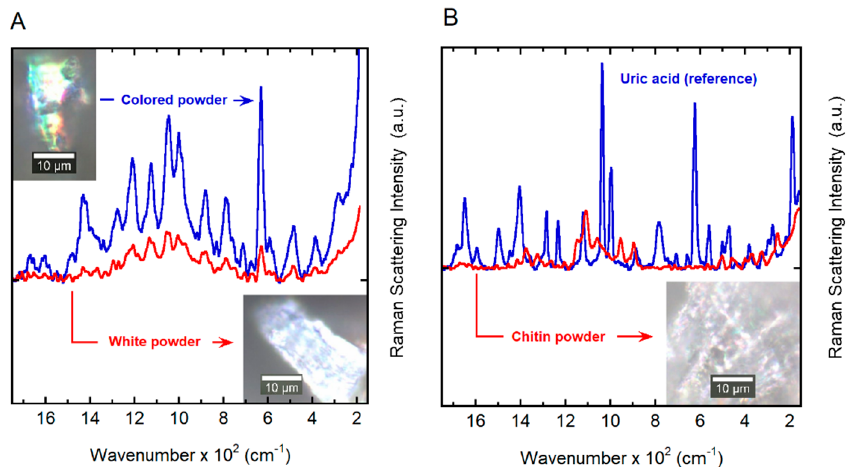
Figure 5. Spectral dependence of the Raman scattering intensity. ( A ) Raman spectra of white (lower-right inset) and colored (upper-left inset) powders obtained by scraping of the cuticles of C. optima specimens. ( B ) A reference spectrum of uric acid is shown together with the spectrum of chitin powder obtained from shrimp shells (inset). a.u.: Arbitrary units.